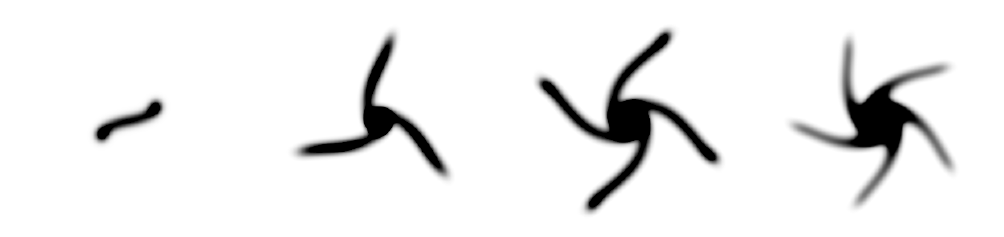
Figure 9 . Intermediate states of the evolution of the MP black hole with a = 3, after perturbations = 2 , 3 , 4 , 5 (from left to right). These are again high-contrast density plots, where this with m φ time the minimal value that appears as black was chosen low enough to highlight the full structure, i.e., these plots do not represent well that the relative mass density, which is higher in all places where blobs form.